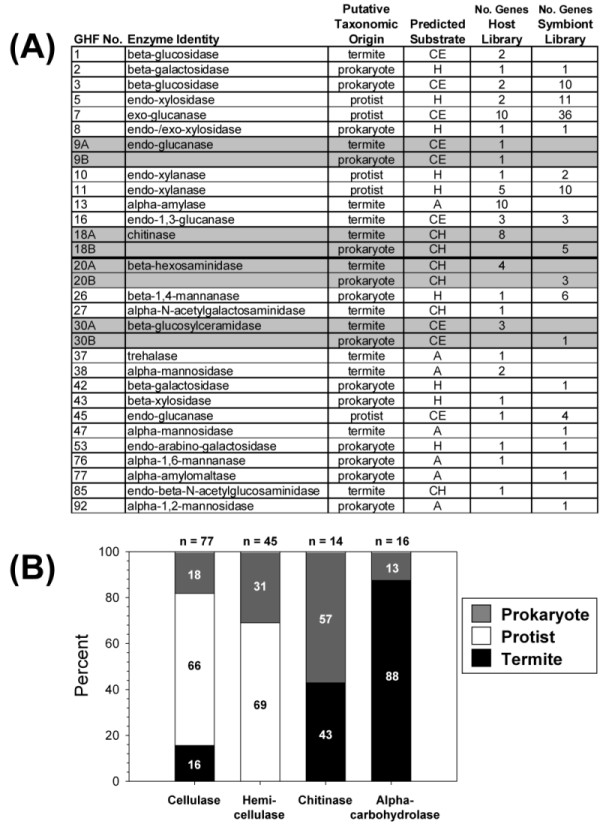
Distributions of expressed sequence tags (ESTs) encoding glycosyl hydrolase family (GHF) proteins generated from the host gut tissue and hindgut symbiont libraries. (a) A summary of GHF family members with enzyme identities and putative taxonomic origins that were determined based on library of origin and database homology. Shaded rows depict GHF families with representatives from both termite and putative prokaryotic symbionts. CE = cellulase, H = hemicellulase, CH = chitinase, A = α carbohydrolase. (b) Bar graph summarizing the taxonomic distributions of cellulase, hemicellulase, chitinase and α carbohydrolase genes among prokaryotic, protist and host genomes. See Additional file 1 for gene by gene summaries and Additional file 3 for Genbank accession numbers.